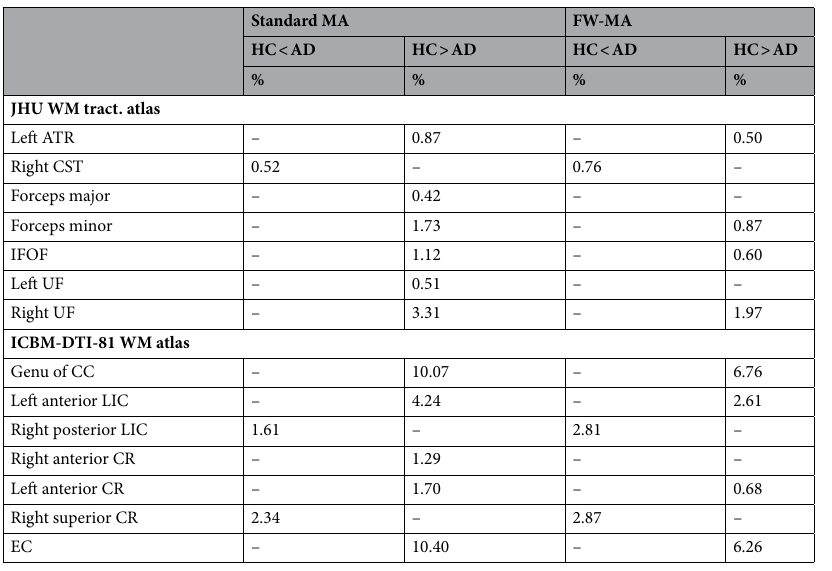
Table 4. Brain locations where clusters of significant differences between groups were found for MA index analysis at p < 0.01 (FWE corrected). % columns indicate the percent volume of the cluster inside the corresponding brain area. For JHU white-matter tractography atlas: ATR anterior thalamic radiation, CST cortical spinal tract, IFOF inferior fronto-occipital fasciculus, ILF inferior longitudinal fasciculus, UF uncinate fasciculus. For ICBM-DTI-81 white-matter atlas: CC corpus callosum, LIC limb of internal capsule, CR corona radiata, EC external capsule, SFOF superior fronto-occipital